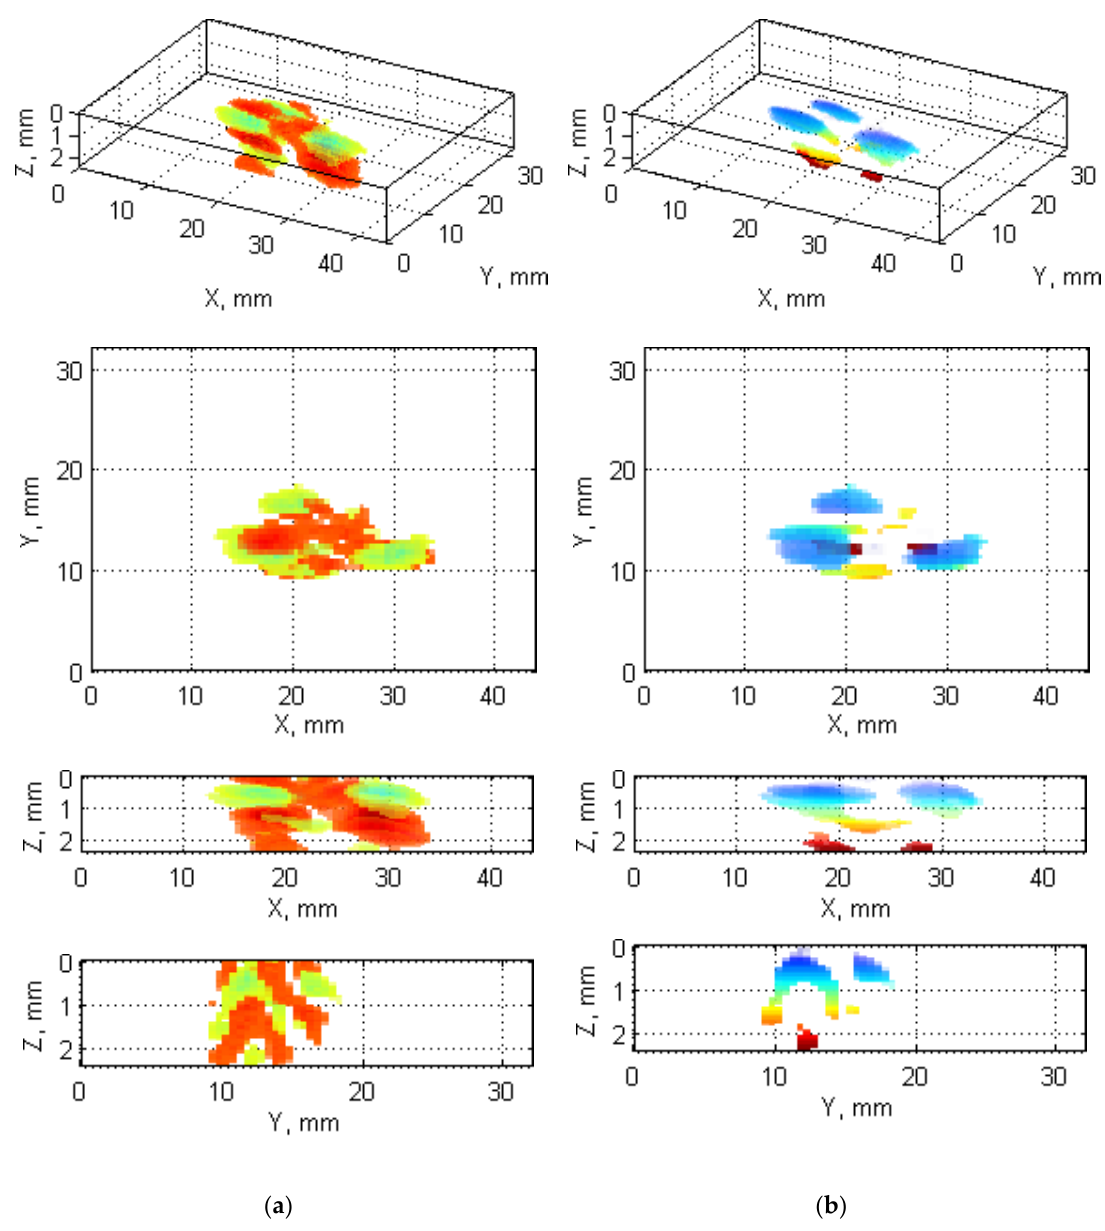
Figure 9. Visualization of the reconstructed damage based on UT B-Scans: ( a ) all regions beyond two thresholds; ( b ) regions below the first threshold.